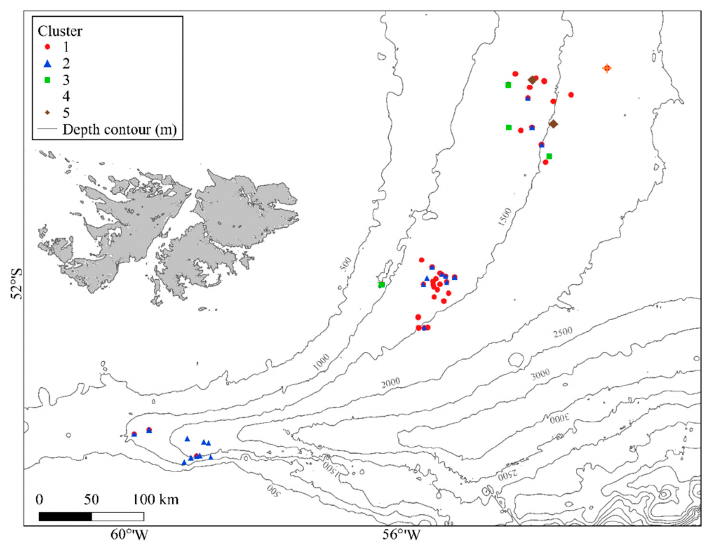
Figure 4. Spatial distribution of clusters identified from hierarchal clustering of Hellinger distance matrix of transformed morphospecies density data.